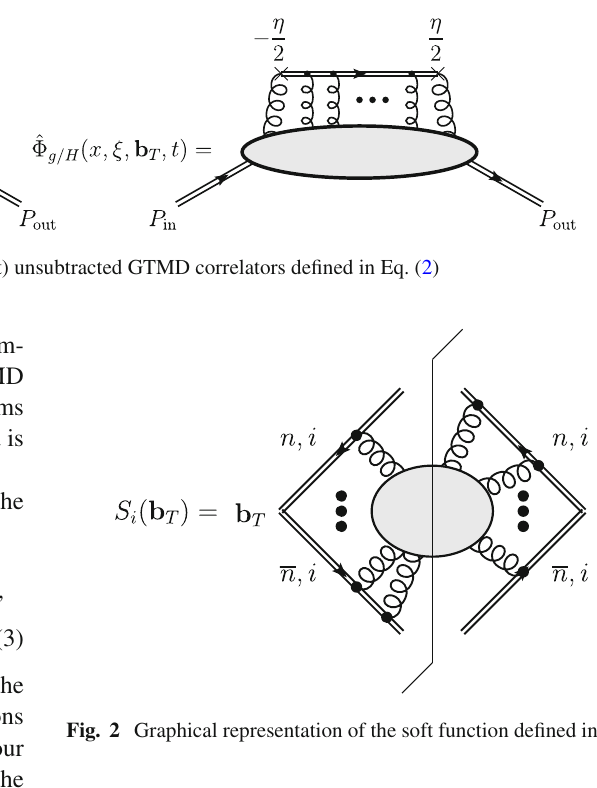
and at the space-time point with transverse displacement b T